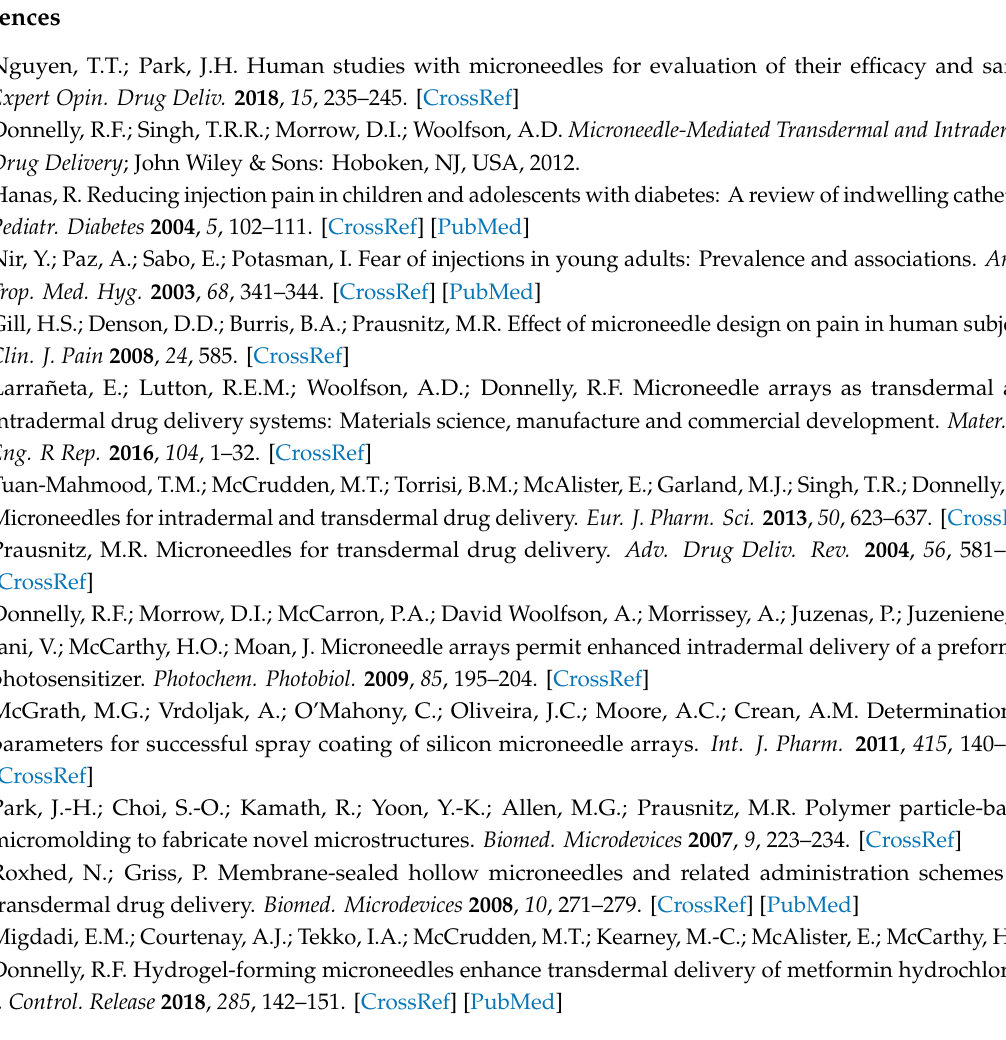
Figure S1: Number of studies included by country, Figure S2: Risk of bias summary of randomized controlled trials (RCT), Figure S3: Risk of bias summary of controlled clinical trials (CCTs), Table S1: Grade of adverse event by Common Terminology Criteria for Adverse Events (CTCAE), Table S2: Analysis of outcomes in included studies, Table S3: Type of adverse events reported in each